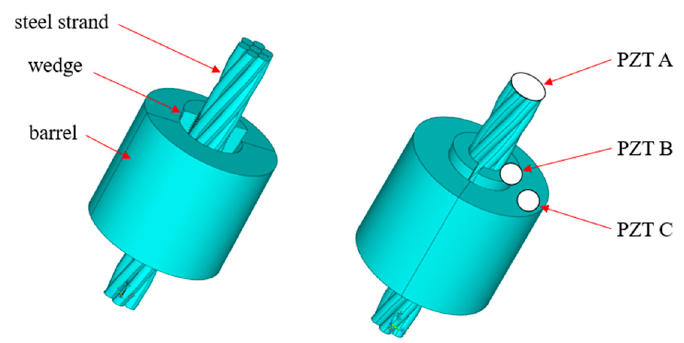
Figure 11. Wedge anchorage system and paste position of lead zirconate titanate (PZT) patches.